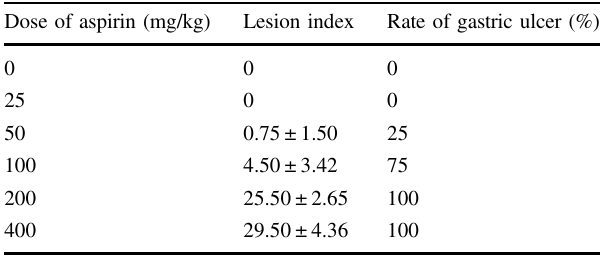
Table 1 Lesion index of gastric mucosal and rate of gastric ulcer of rats induced by aspirin (Mean ± SD, n = 4) Dose of aspirin (mg/kg) Lesion